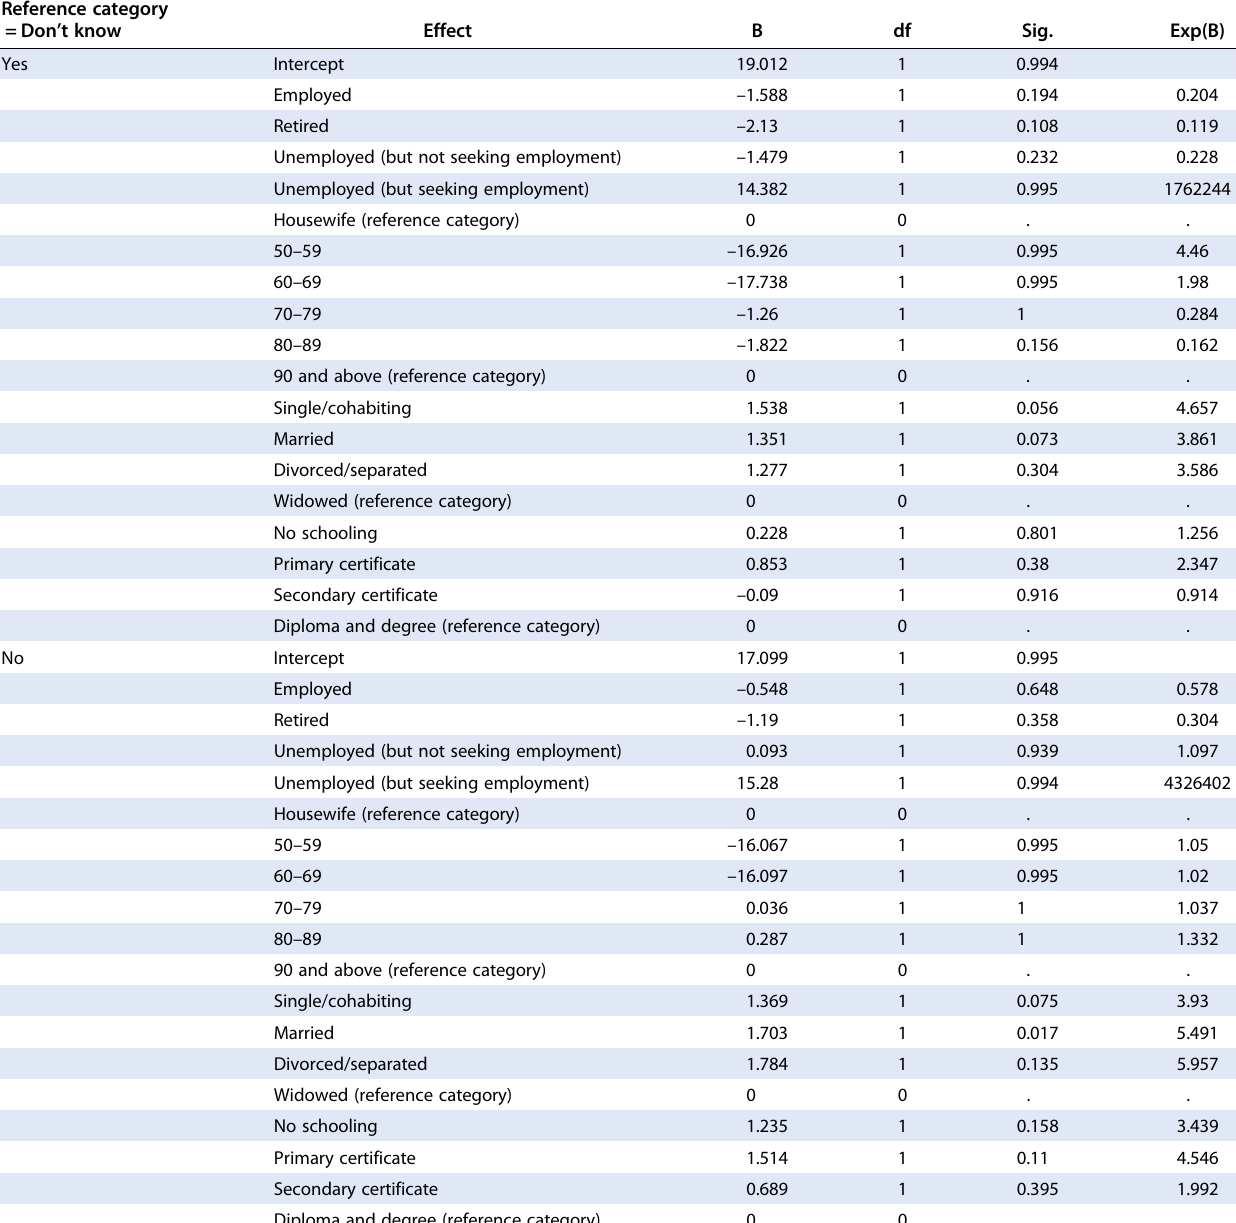
Table 5: Multinomial logistic regression model Reference category = Don ’ t